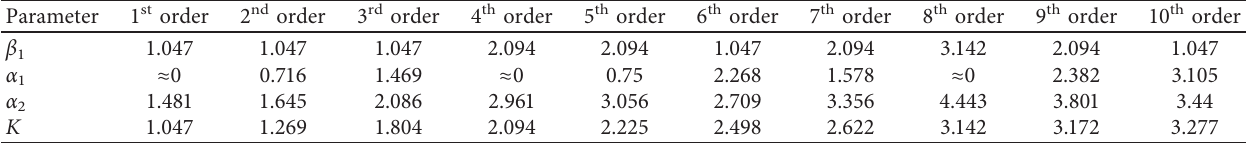
Table 2: The first 10 order vibration parameters of the thin plate rock mass under free vibration (S-F-S-F). Parameter